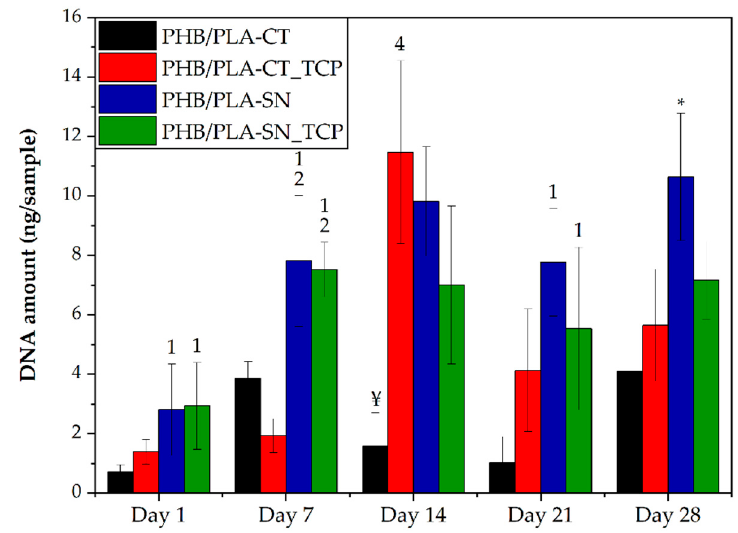
Figure 4. Cell proliferation. The number above the column indicates statistically significantly higher values compared to the column of that number, p < 0.05. * means the statistically highest value of all groups for a given day, ¥ means the statistically lowest value of all groups for a given day.